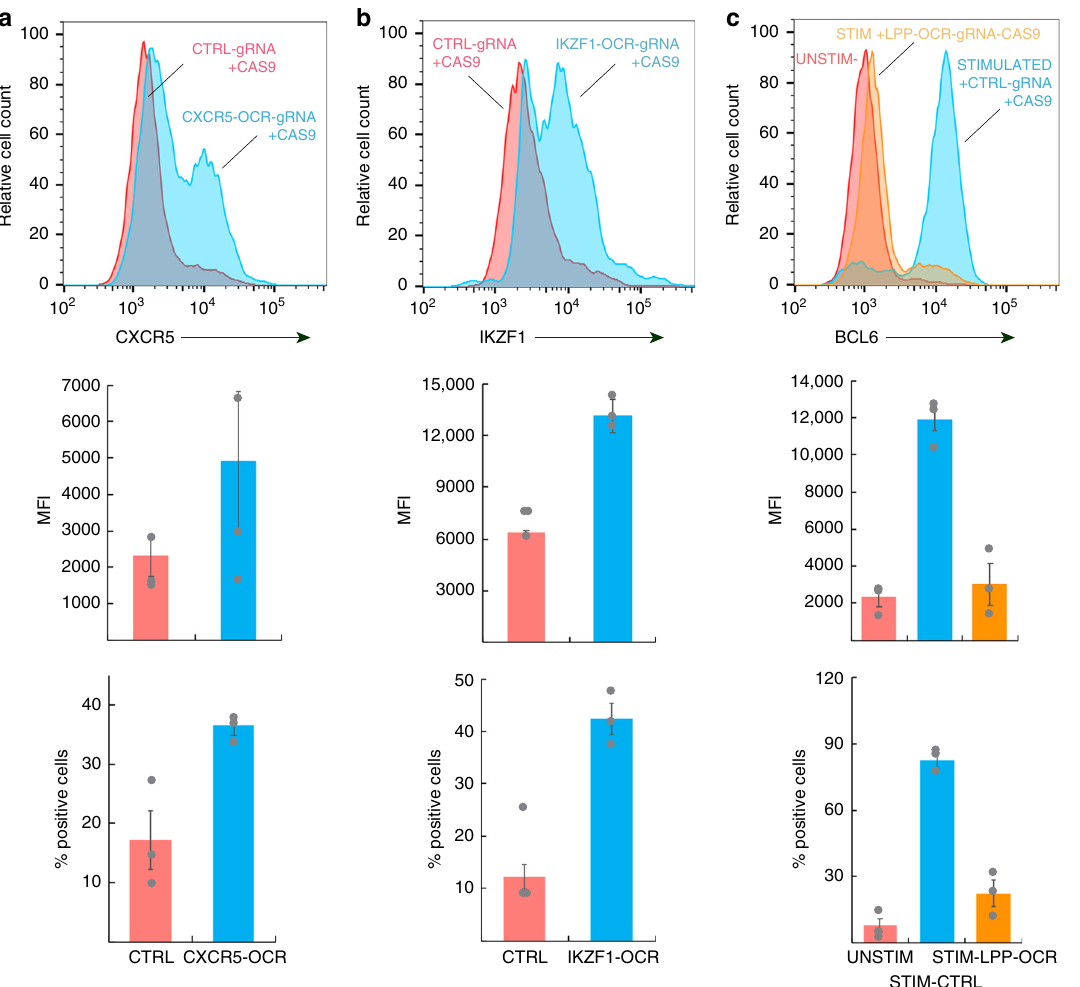
Fig. 8 CRISPR/CAS9-based deletion of accessible, promoter-connected genomic regions harboring SLE variants in fl uences TFH gene expression. a , CRISPR – CAS9 targeting of the 136 bp OCR near the TREH gene harboring the rs527619 ( r 2 = 0.51) and rs71041848 ( r 2 = 0.44) SLE proxy SNPs and captured interacting with the CXCR5 promoter leads to increased CXCR5 expression (blue histogram) by Jurkat cells compared to cells transduced with a CTRL-gRNA + CAS9 (pink histogram). b CRISPR – CAS9 targeting of the 213 bp OCR containing the rs4385425 SLE proxy ( r 2 = 0.99) to rs11185603 and captured interacting with the IKZF1 promoter leads to increased IKZF1 (Ikaros) expression (blue histogram) by Jurkat cells compared to cells transduced with a CTRL-gRNA + CAS9 (pink histogram). c CRISPR – CAS9 targeting of the LPP SLE proxies rs34631447 ( r 2 = 1.0) and rs79044630 ( r 2 = 0.8) captured interacting with the BCL6 promoter abrogates IFNg-induced BCL-6 expression (orange histogram) compared to cells transduced with a CTRL-gRNA + CAS9 (blue histogram). The red histogram shows BCL-6 expression by unstimulated Jurkat cells. Graphs in a – c depict biological replicate (circles) and mean (bars) fl uorescence intensities (upper panels) and biological replicate (circles) and mean (bars) percent positive cells (lower panels) ±SEM (error bars) for CXCR5, Ikaros, and BCL-6 in control gRNA-tranduced vs. targeted cells. All data are representative of three independent experiments. See Supplementary Fig. 7 for design and validation of CRISPR/CAS9-mediated deletion and mutation. Source data are provided as a Source Data fi